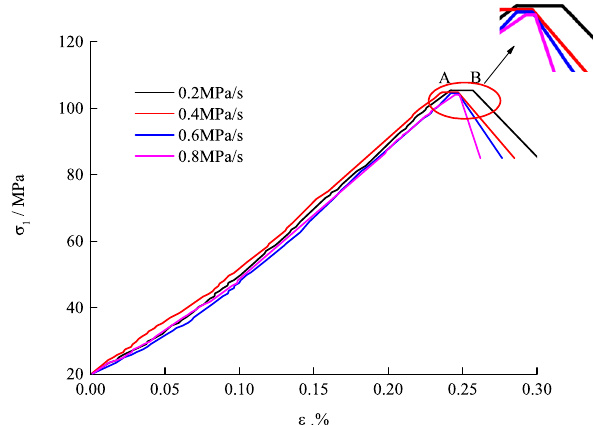
Figure 2. Stress–strain curves in the failure process of marble at different unloading rates.